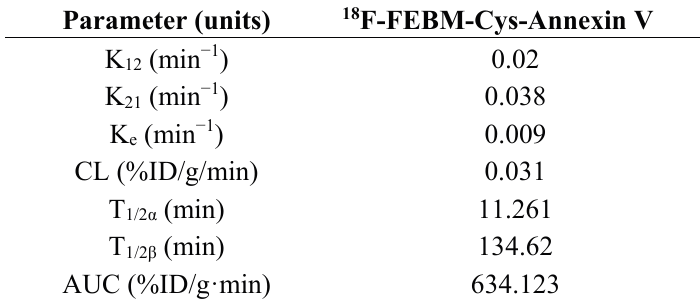
Table 1. Pharmacokinetic parameters of the 18 F-FEBM-Cys-Annexin V in mice.